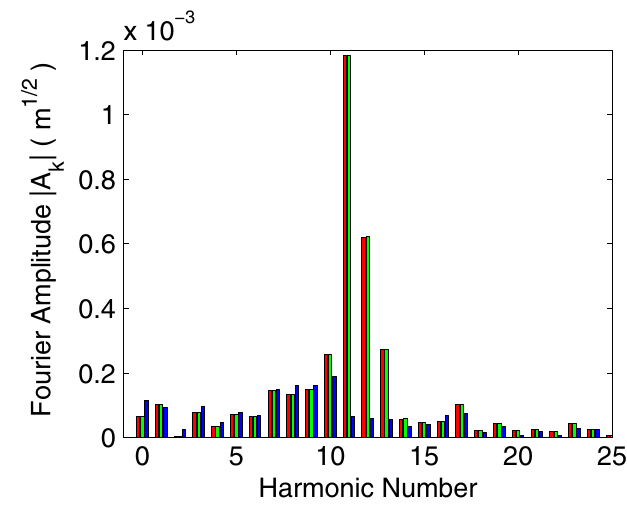
FIG. 9. (Color) Fourier harmonics of the normalized vertical dispersion function before (red bars) and after (blue bars) stop band correction show that the harmonic correction is effective in reducing the vertical dispersion. The linear betatron-coupling correction does not alter the Fourier harmonics of the vertical dispersion function (green